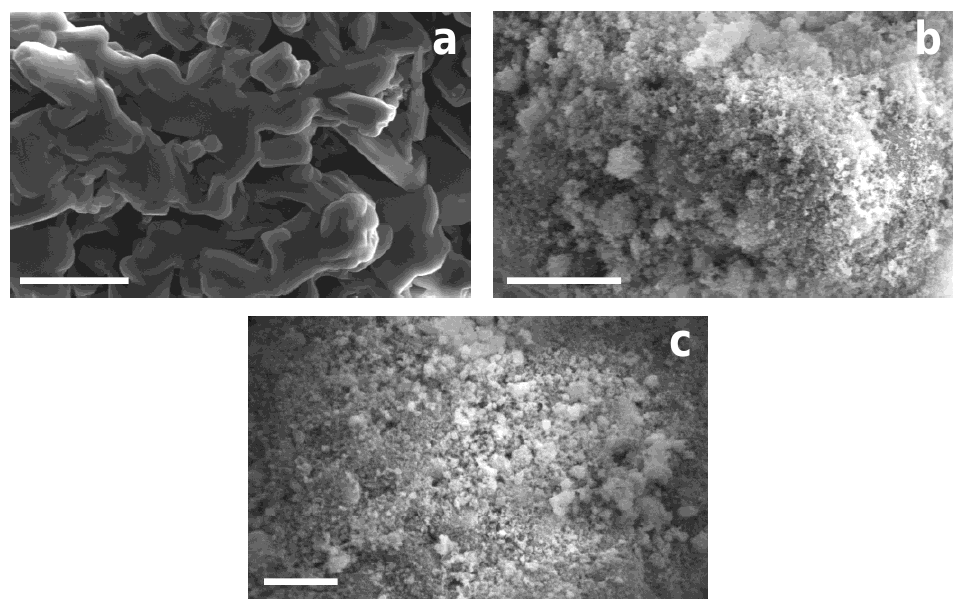
Figure 2. Scanning electron micrographs (SEM) of coating materials: ( a ) L-lysine (Lys); ( b ) hydroxyapatite (HA); and ( c ) hydroxyapatite/L-lysine (HA/Lys) composite. Scale bars: ( a ) 10 µm; ( b , c ) 5 µm.